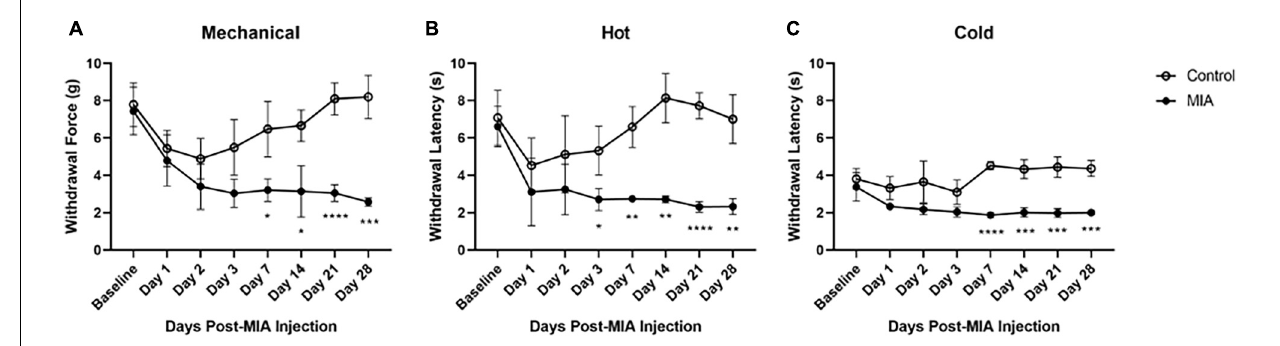
FIGURE 1 | Hypersensitivity to mechanical, heat, and cold stimuli after MIA induction. Mice were tested for hypersensitivity to mechanical (A) , heat (B) , and cold (C) stimuli using the von Frey, Hargreaves, and crushed dry ice assays over 28 days following MIA injection. MIA ( n = 5) and control ( n = 6). Data are represented as mean ± SD (* p < 0.05; ** p < 0.01; *** p < 0.001; **** p < 0.0001). Two-way ANOVA with repeated measures and Geisser–Greenhouse and Sidak